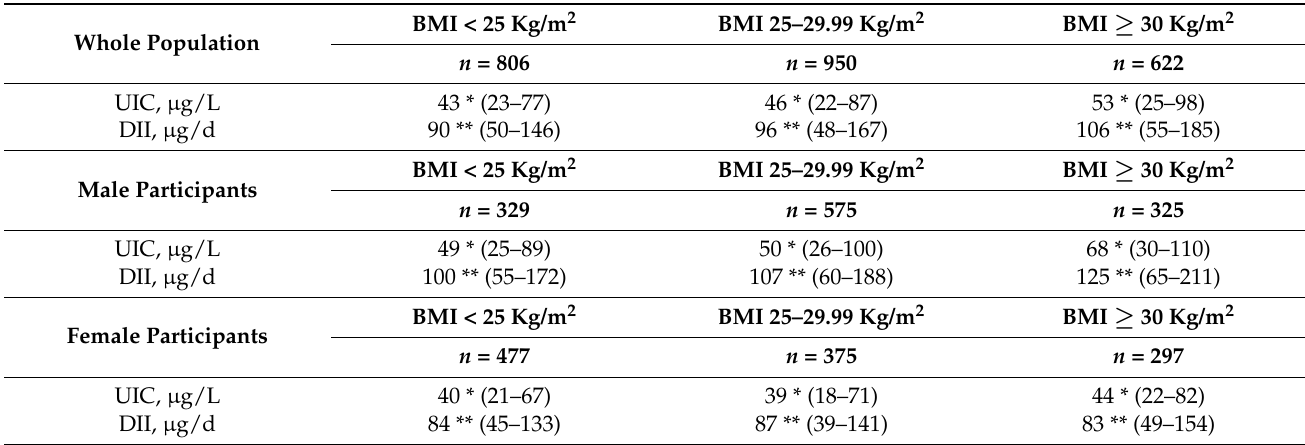
Table 3. Medians (IQR) of urinary iodine concentration (UIC) and daily iodine intake (DII) by BMI class in the whole study population and by